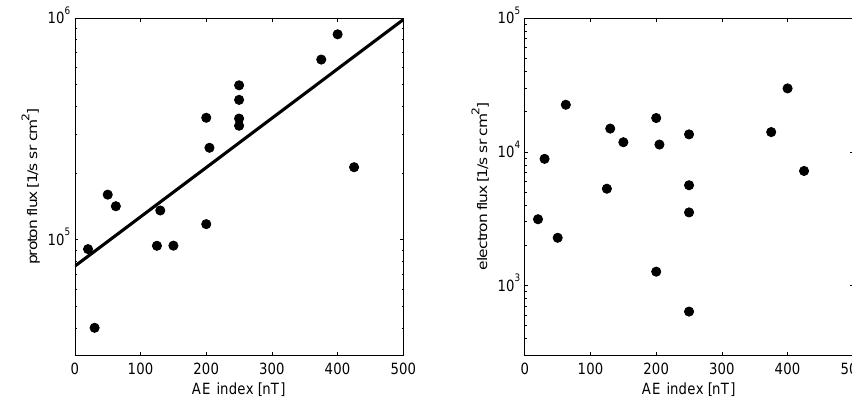
Fig. 13. Energetic particle fluxes in the HLPS as a function of 3-h averaged AE index. Left: protons, right: electrons.